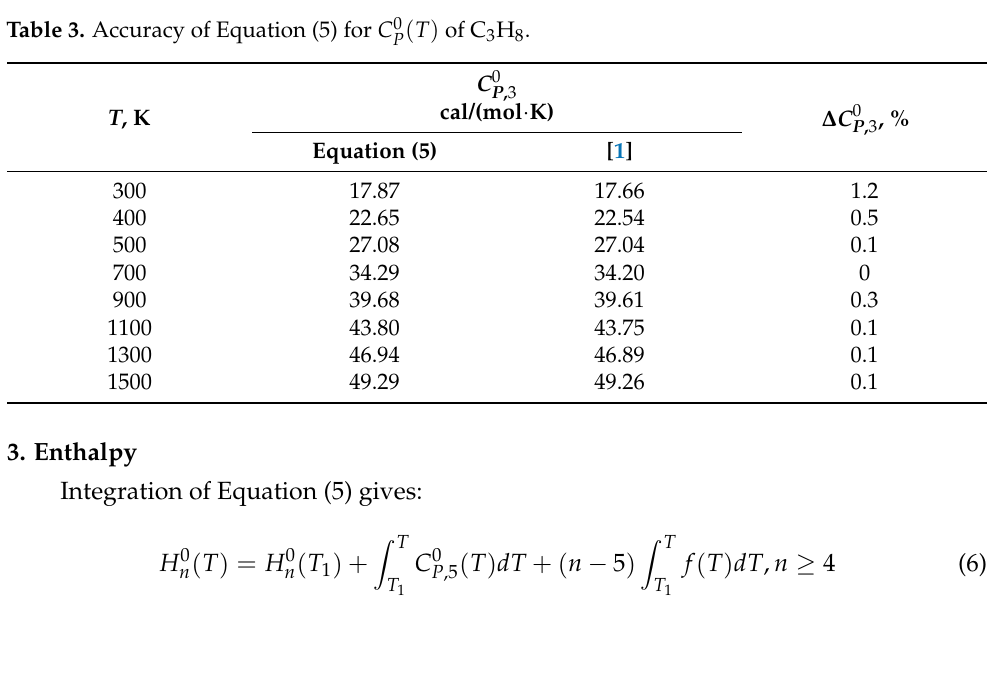
Table 3. Accuracy of Equation (5) for C 0